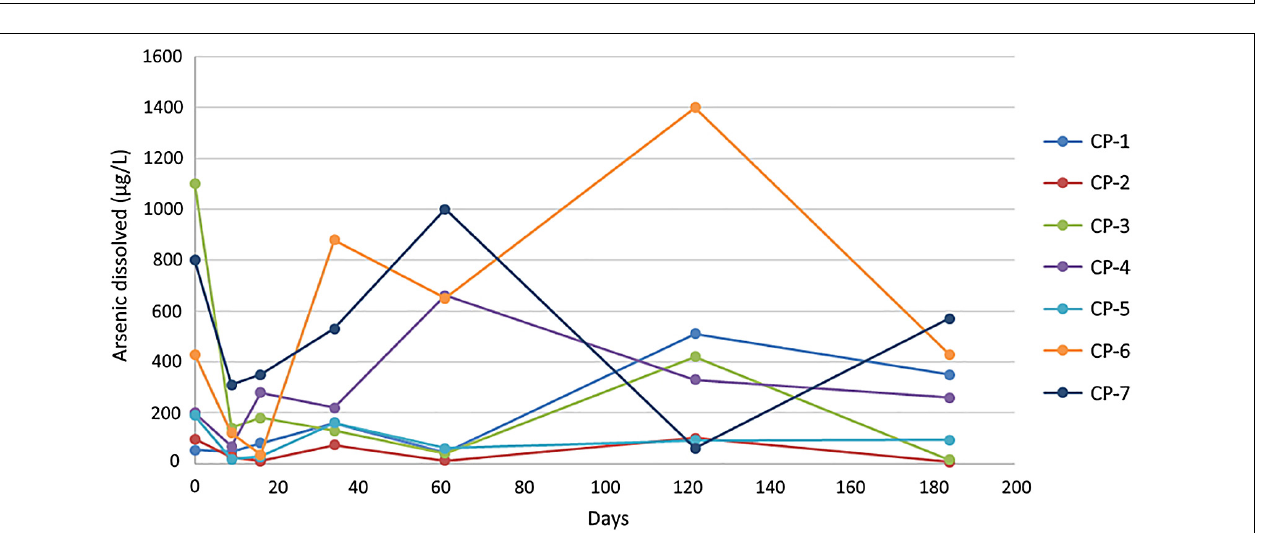
pH of the groundwater after the application of nZVI ( Figure 3A